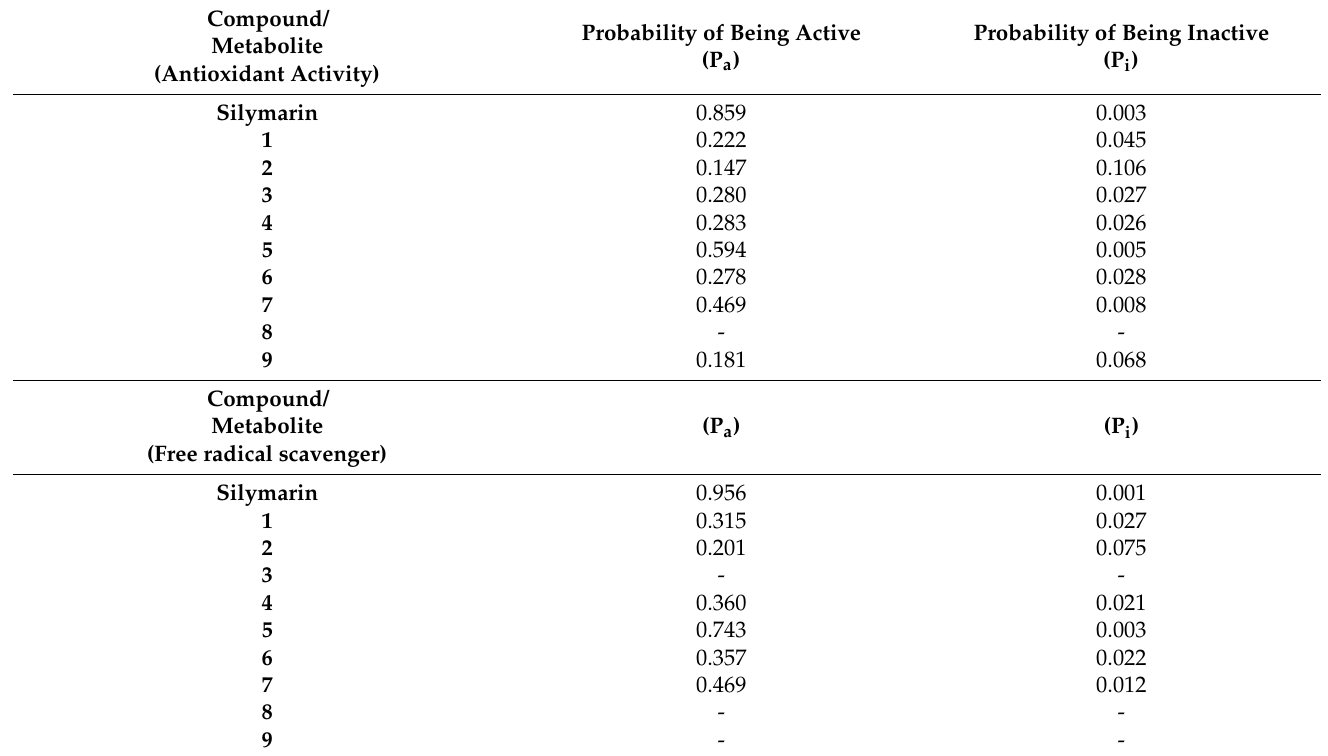
Table 1. Bioactivity scores for antioxidant and free radical scavenger activities of identified BERM- derived metabolites using the PASS online web server.